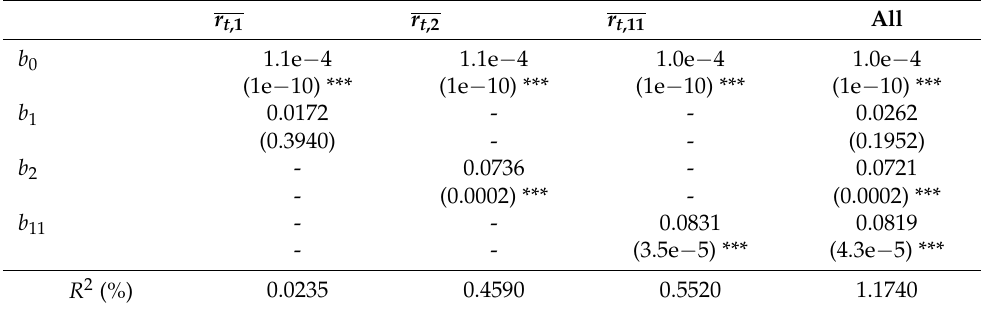
Table 10. Estimation results of Market Intraday Momentum, standardized returns. r t ,1 r t ,2 r t ,11 All b